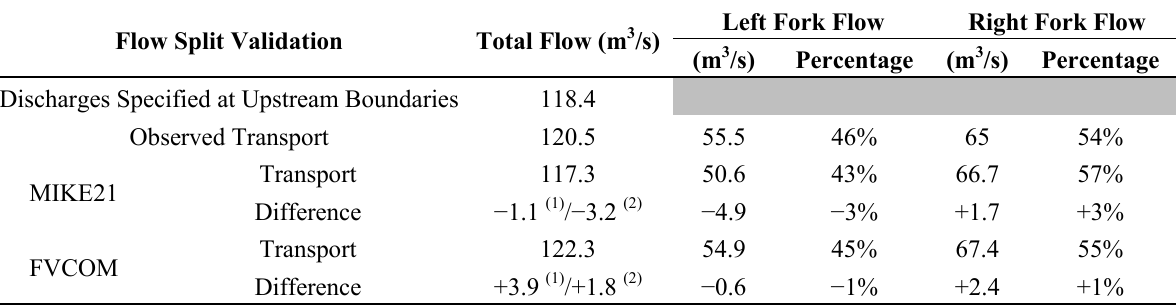
Table 2. Model Results for Flow Split